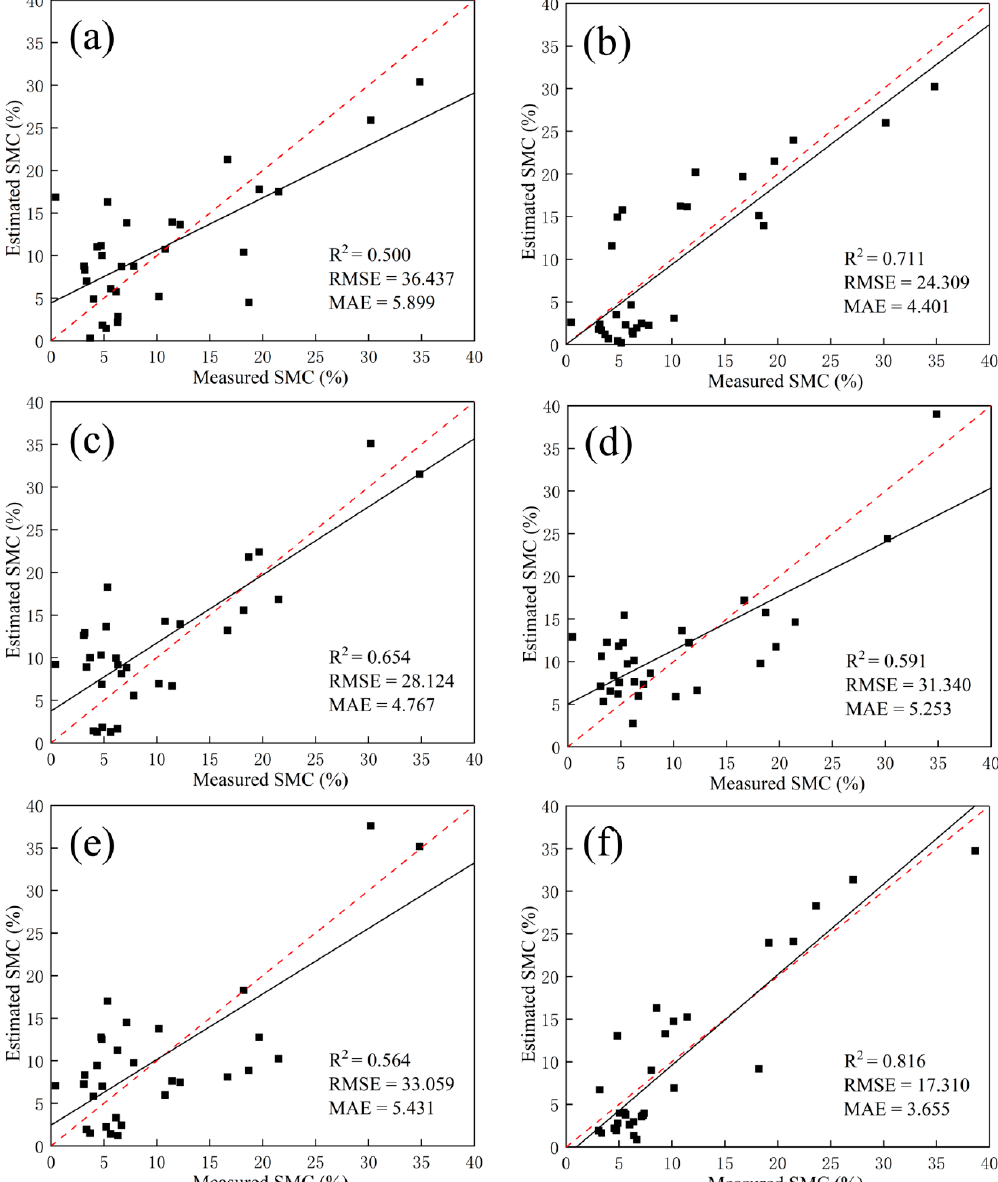
Figure 5. The comparison of measured and estimated SMC: ( a ) EVI; ( b ) TVI; ( c ) DSI; ( d ) NDMI; ( e ) SARVI; ( f ) PLSR model of five spectral indices.